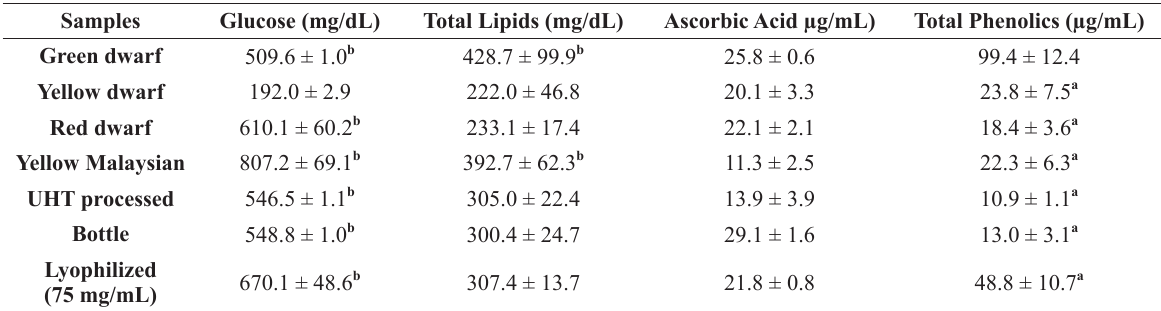
Comparison of the constituents of four coconut varieties, industrialized products and lyophilized coconut